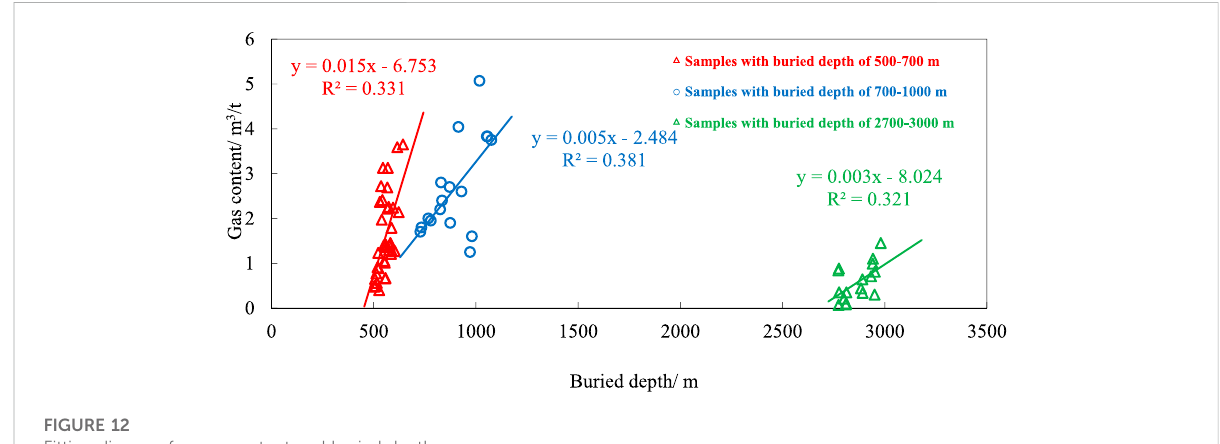
FIGURE 12 Fitting diagram for gas content and buried depth.